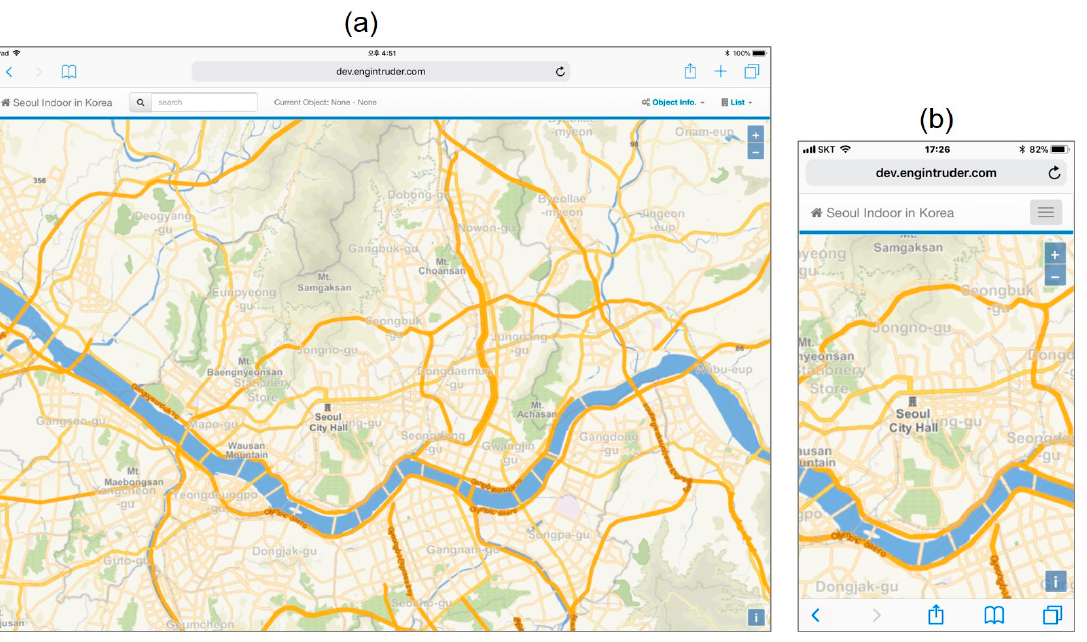
Figure 8. Main page of the mobile web mapping service for indoor facilities for foreigners using ( a ) iPad mini and ( b ) iPhone.